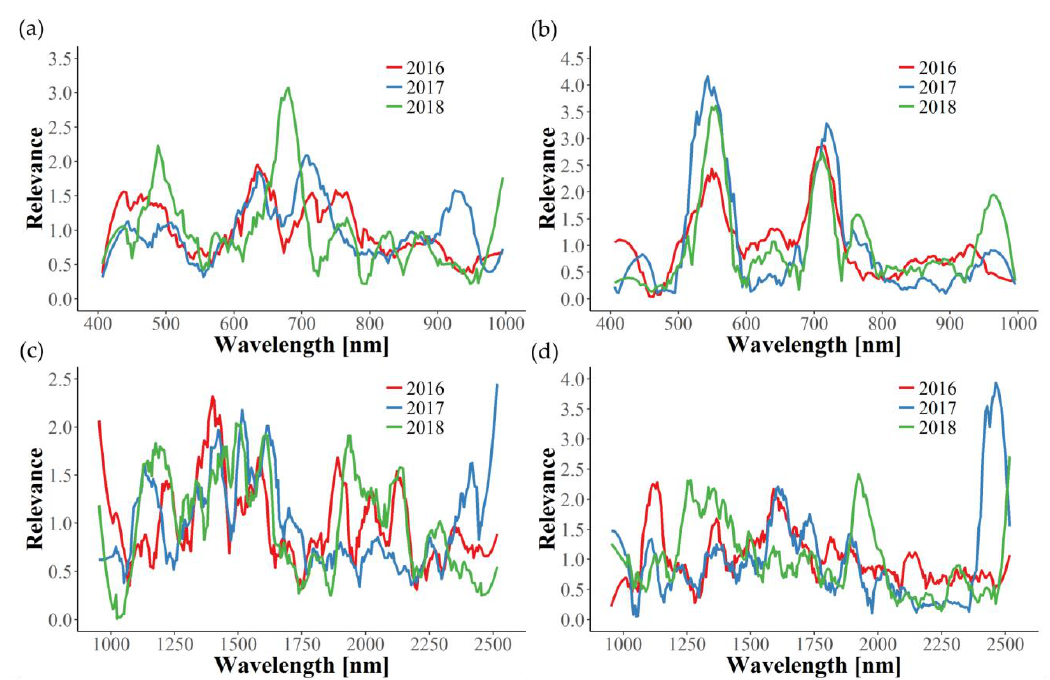
Figure 4. Spectral relevance profiles for VNIR ( a , b ) and SWIR ( c , d ) in three consecutive years regarding white ( a , c ) and red ( b , d ) cultivars infected with GLRaV-1.